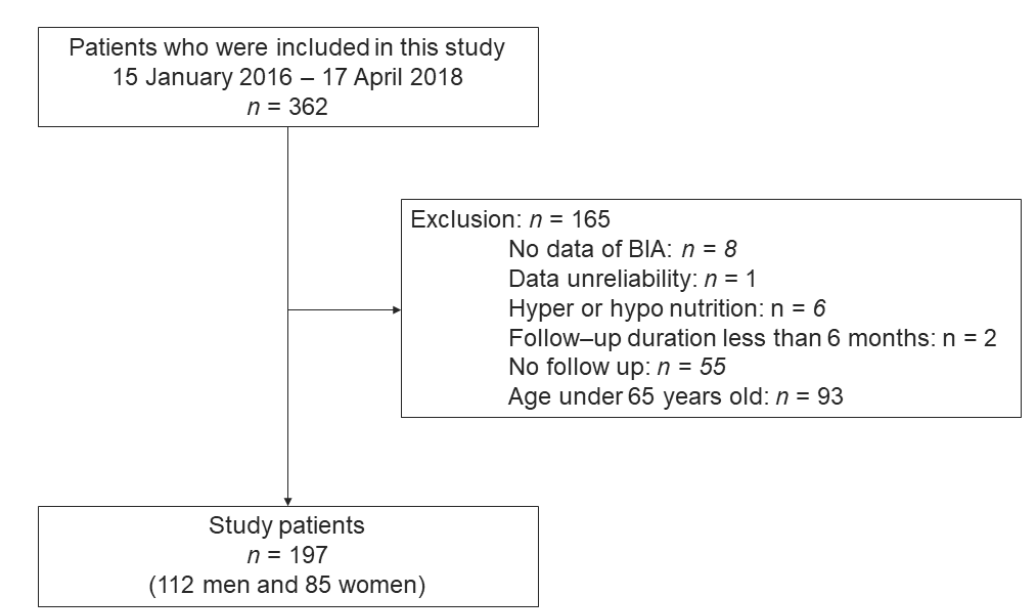
Figure 1. Inclusion and exclusion flow.